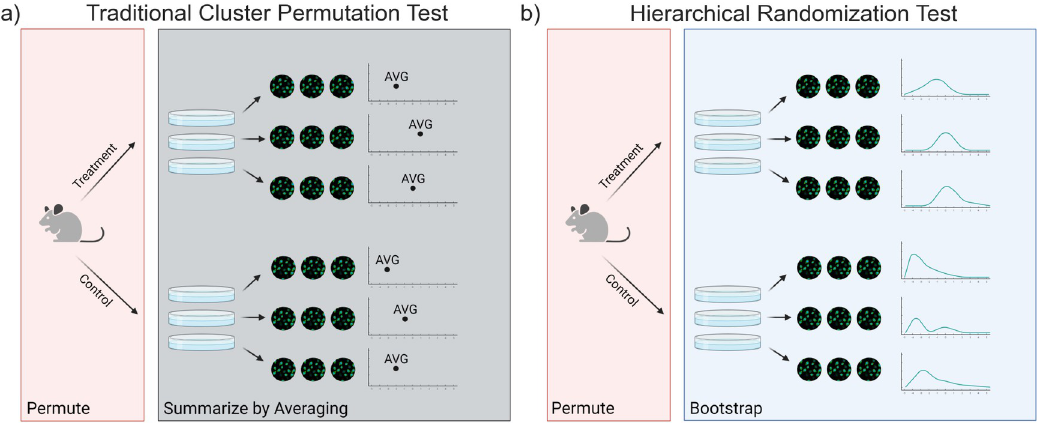
Fig 3. Hierarchical randomization combines permutation and bootstrapping to perform a hypothesis test. (A) By averaging, traditional cluster-based permutation tests shuffle discard information from the levels of hierarchy that arise due to treatment assignment. (B) Hierarchical randomization tests use bootstrapping to compute posterior distributions of the mean for each treated sample, thereby using all of the data collected to compute a p-value. Figure was created using BioRender.com.